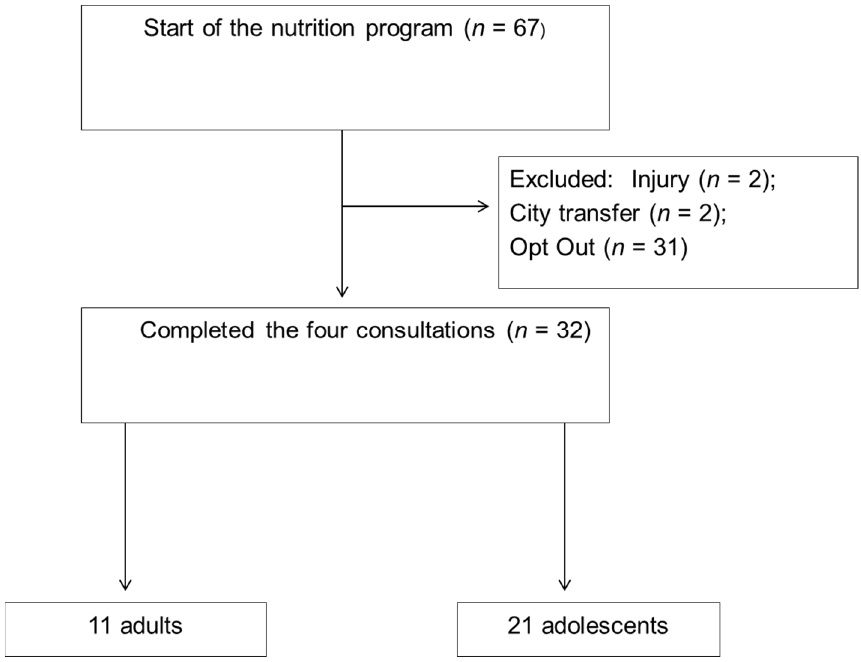
Figure 3. Study diagram.